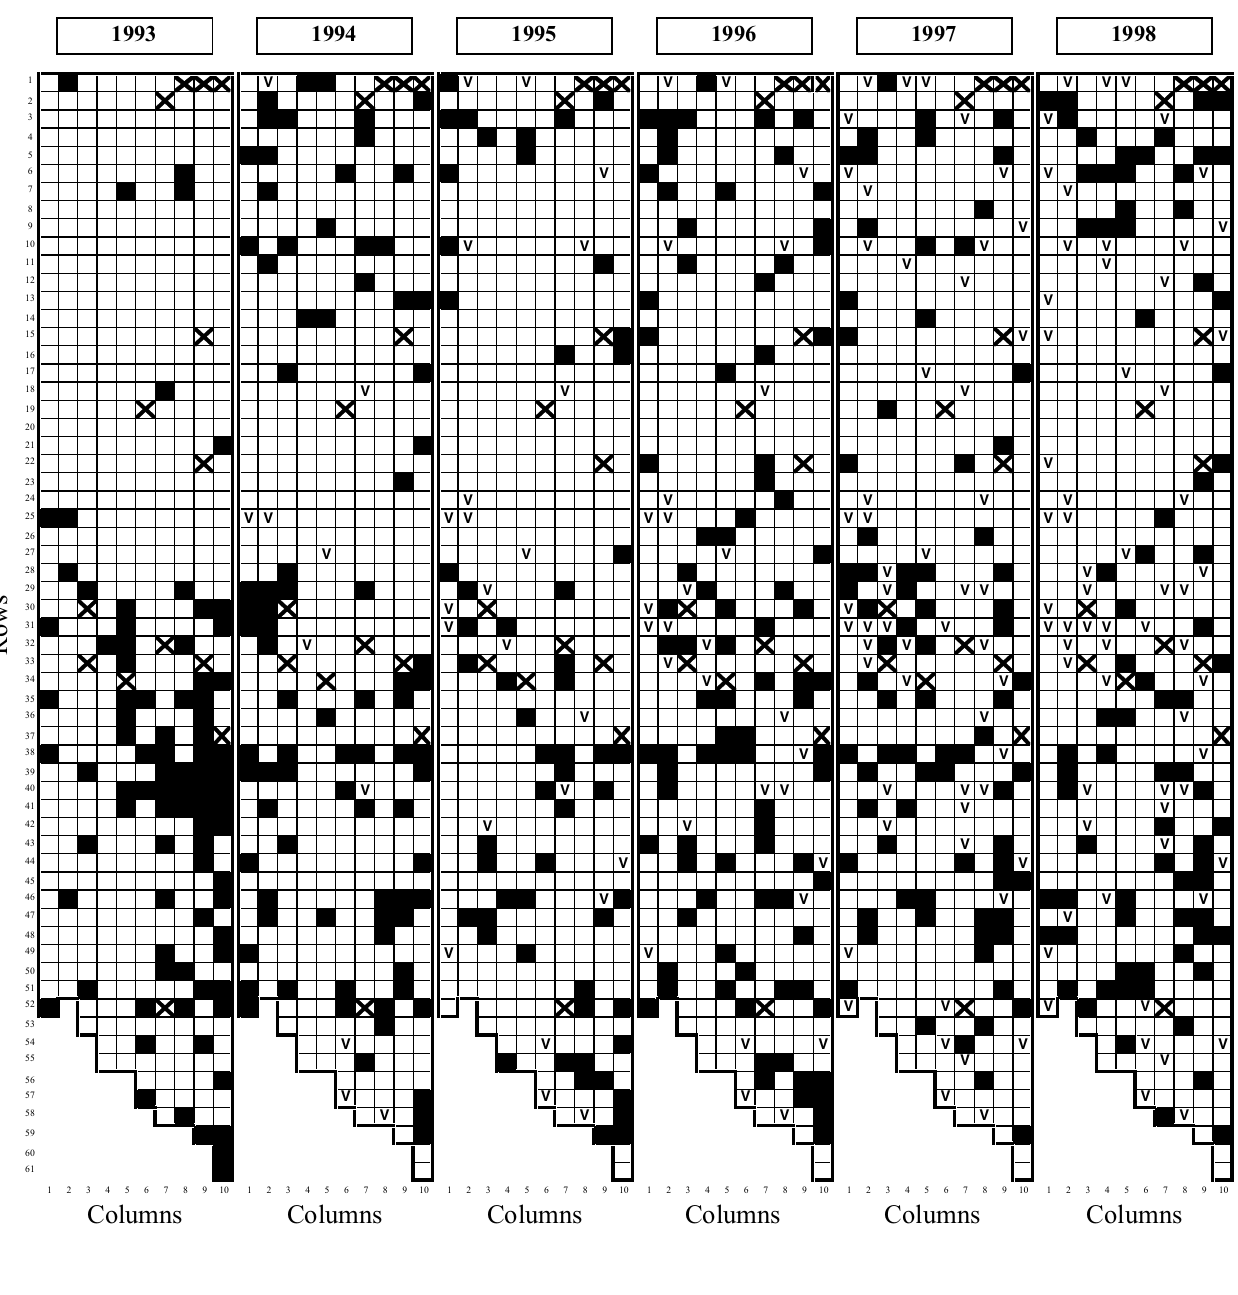
Fig. 3. Annual spatial pattern of esca-diseased plants in a vineyard at Gambassi Terme in the province of Florence. Black squares, symptomatic plants; open squares, asymptomatic plants; “ X ”, plants died before start of survey (cause unknown); “ V ”, plants died during survey period, with or without esca symptoms in the previous year.